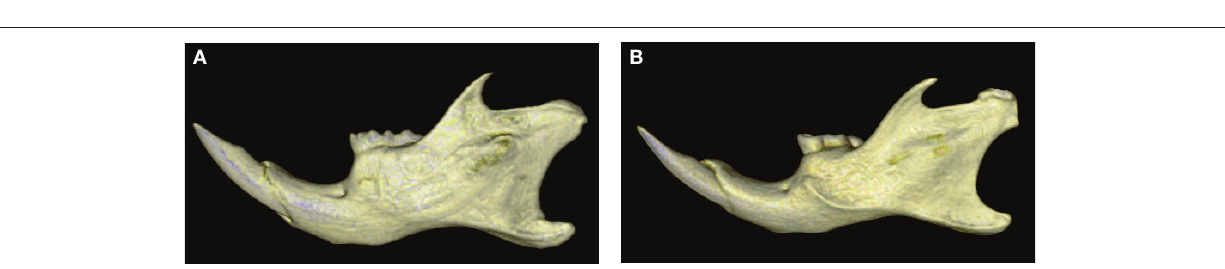
Figure 6 | Morphological comparison of the mandibular morphology between WT (A) and hemizygous Tabby (B) specimens. The 3D reconstructions illustrate the marked backward projection of the coronoid process, the narrower neck of the condyle, and the lower corpus of the mandible in the hemizygous